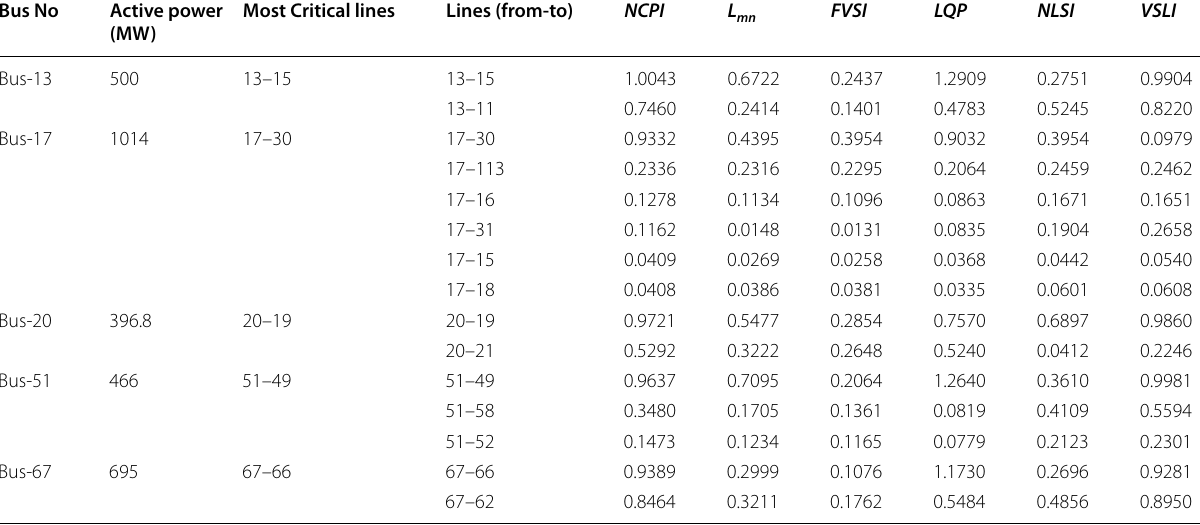
Table 6 The line stability indices for the IEEE 118-bus system under heavy active power load Bus No